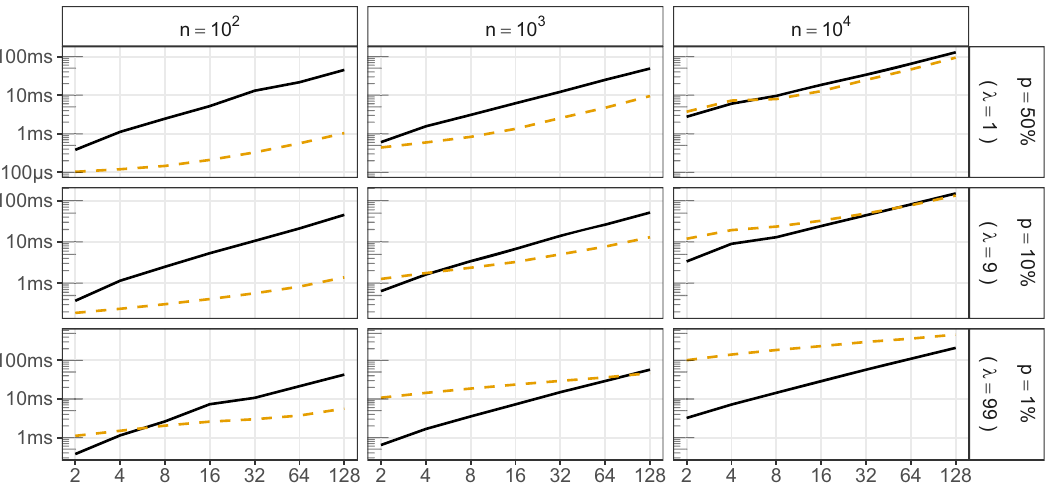
Figure 7: The median runtime of the MDCM ( solid, black ) and LFM ( dashed, yellow ) algorithms for extMO distributions from the exponential family without drift or killing. We used three con fi gurations for various success probabilities p from the fi rst component ’ s ( geometric ) barrier - exceedance count